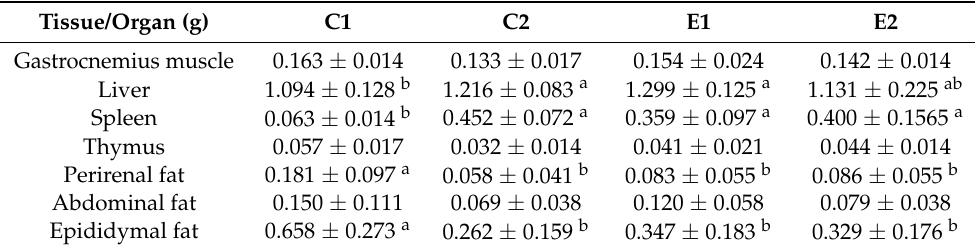
Table 3. Weight of tissues and organs in the four experimental groups. Tissue/Organ